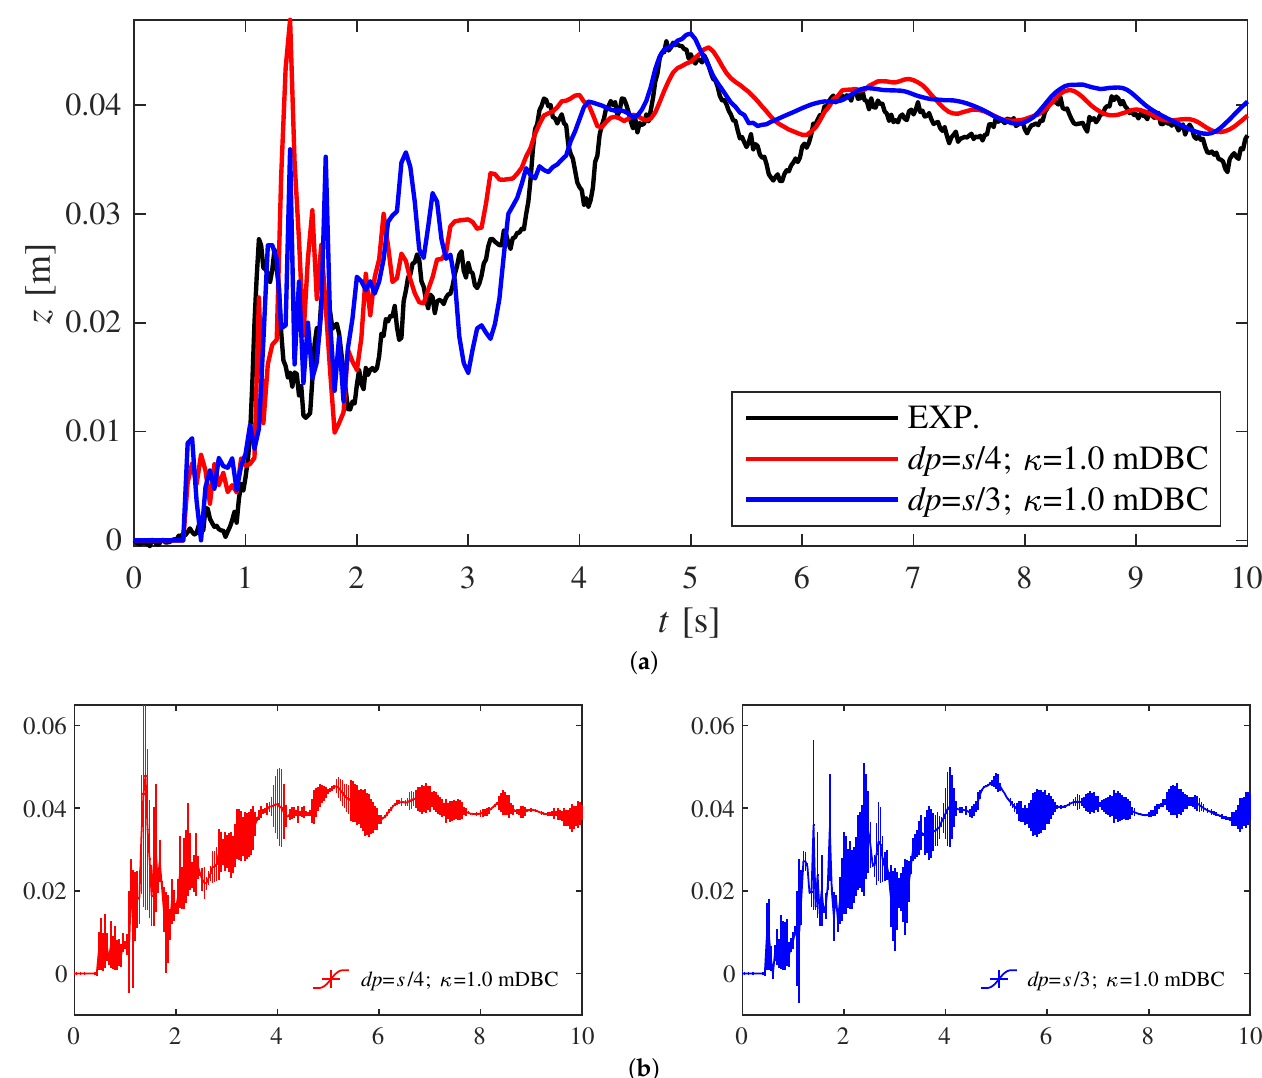
Figure 10. Comparison in P4 ( a ) and relative local elevation error ( b ) with mDBC and different